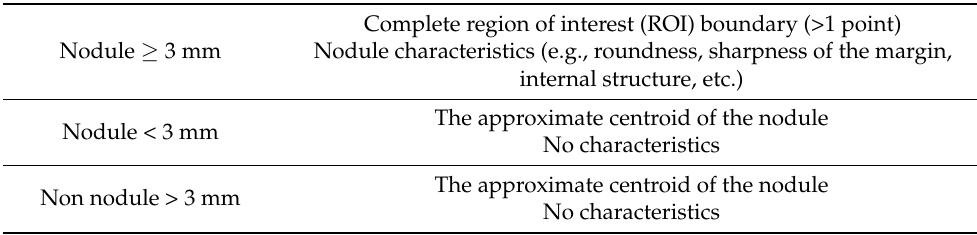
Table 1. Lung abnormalities annotated within the LUNA challenge dataset.